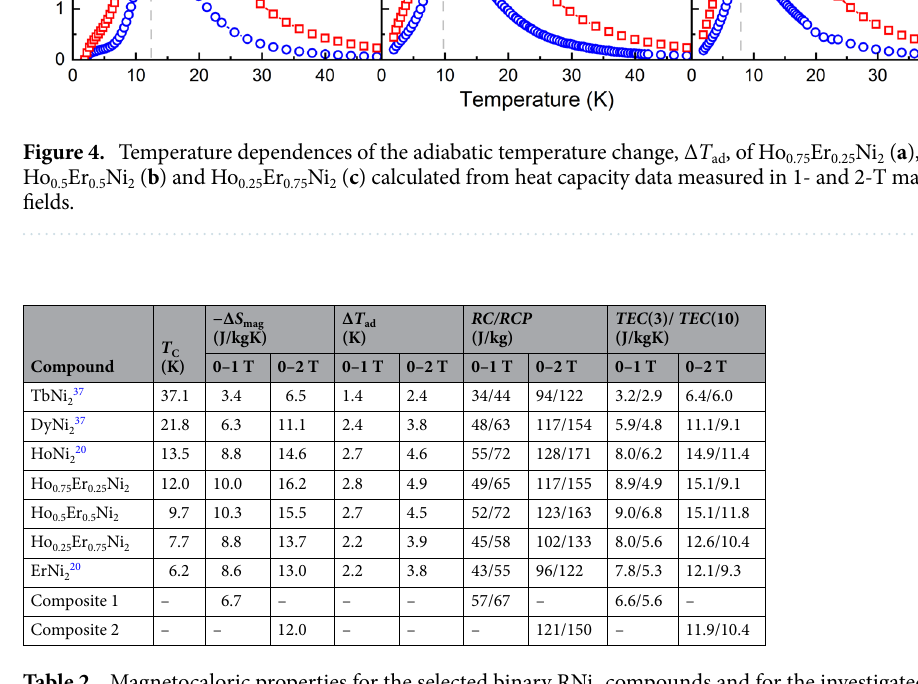
for other pseudo-binary Laves-phase compounds 25,31,32 . According to the theoretical calculations, the maximum magnetic entropy should equal to 23.2–23.4 J/molK. In the case of the tested solid solutions, the maximum value of S mag for Ho 0.75 Er 0.25 Ni 2 and Ho 0.5 Er 0.5 Ni 2 is 21.4 J/molK at 100 K and is 22.3 J/molK for Ho 0.25 Er 0.75 Ni 2 . This means that almost the total magnetic entropy associated with the magnetic process is utilized. near T C decreases from 15.1 to 10.5 J/molK in the applied magnetic field. The temperature dependences of the isothermal magnetic entropy change Δ S mag ( T ) calculated using the heat capacity data according to the procedure field change of 0–2 T, the experimental maximum − Δ S mag in the case of the Ho 0.75 Er 0.25 Ni 2 compound reaches the highest value of 4.6 J/mol K (16.3 J/kg K) near 12.1 K and, as the Er content increases, becomes lower and